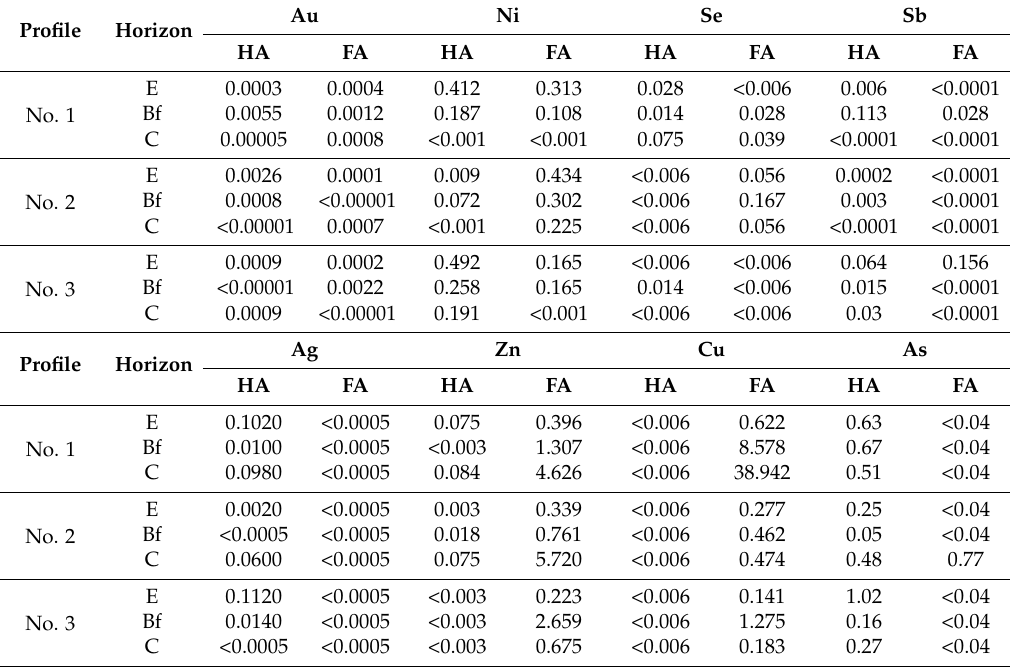
Table 10. Concentrations of elements in HA and FA extracts at Novye